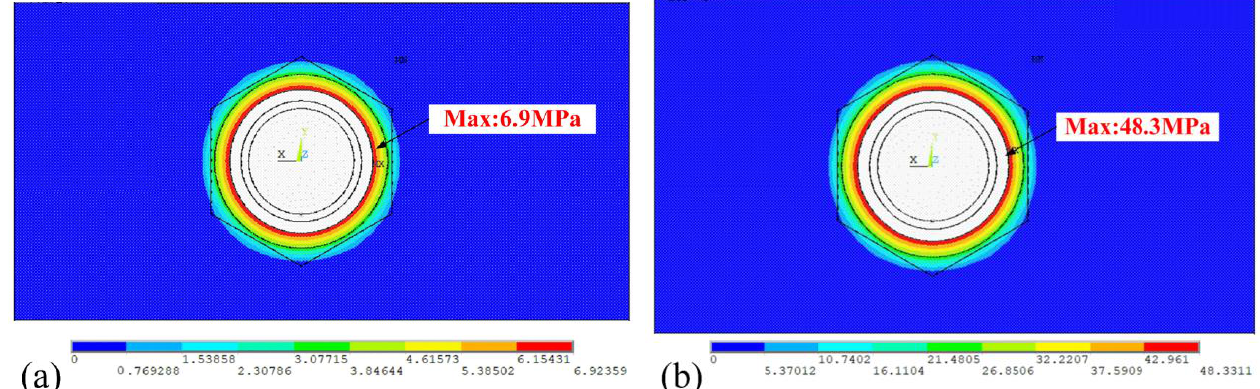
Figure 17. Contact pressure of interfaces under, ( a ) small bolt tension (1 kN), ( b ) large bolt tension (7 kN).